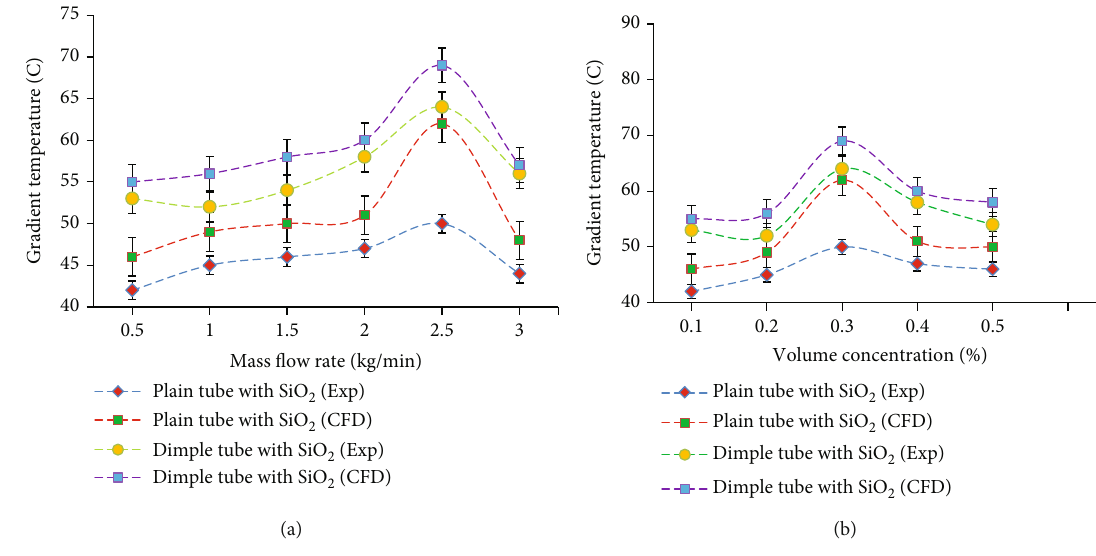
Figure 9: (a) Mass fl ow rate vs. gradient temperature. (b) Volume concentration vs. gradient